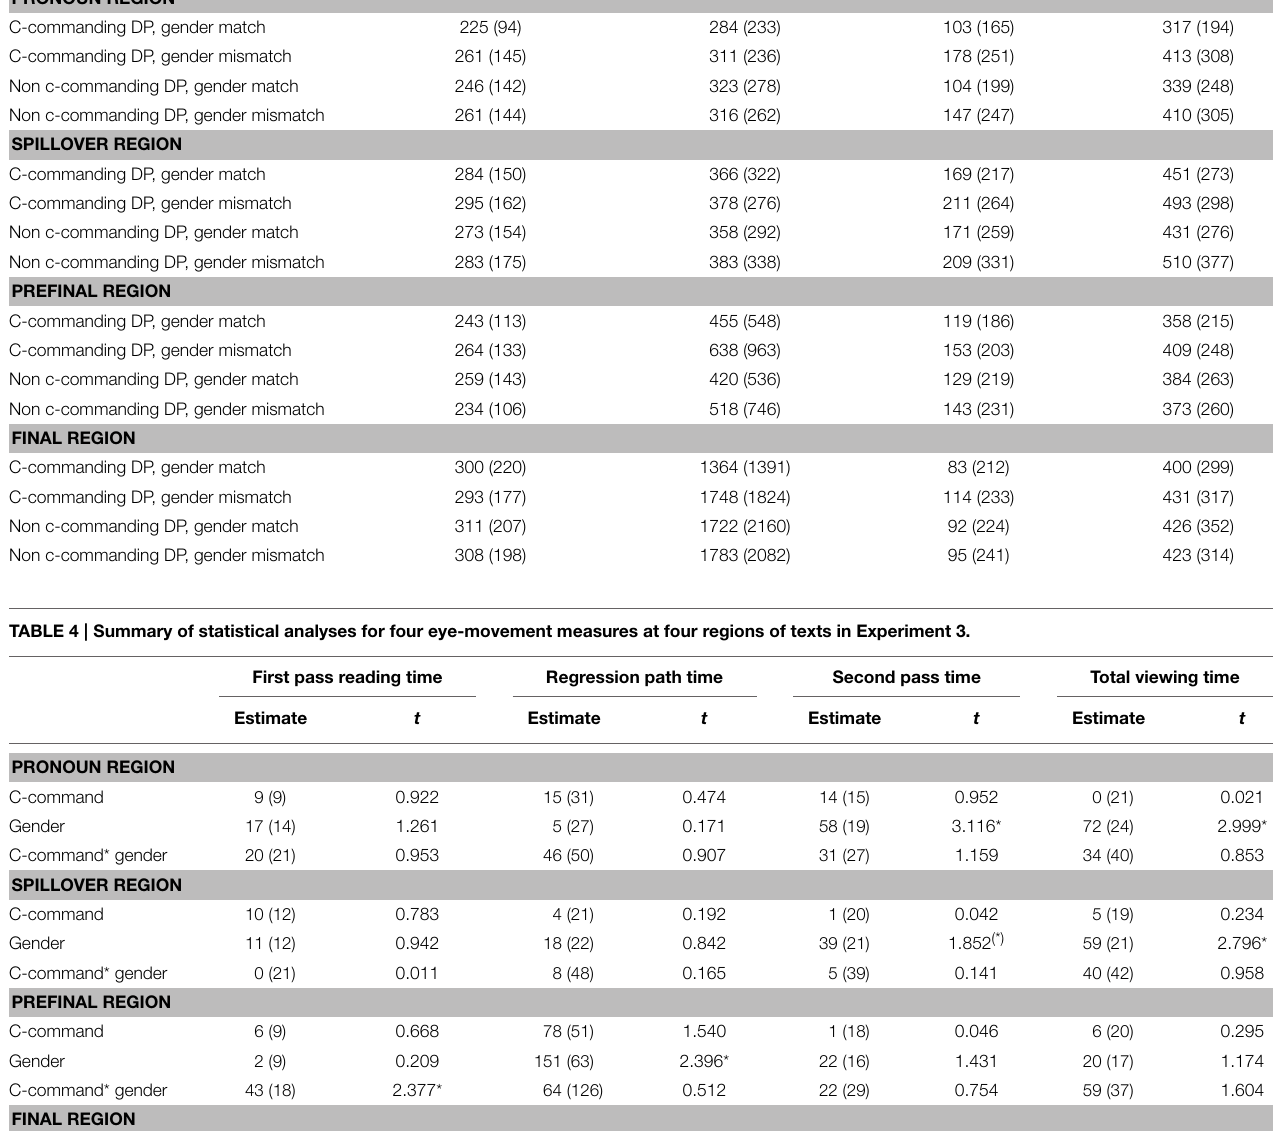
TABLE 3 | Reading times in milliseconds for four eye-movement measures at four regions of texts in Experiment 3 (SDs in parentheses). First pass reading time Regression path time Second pass time Total viewing time